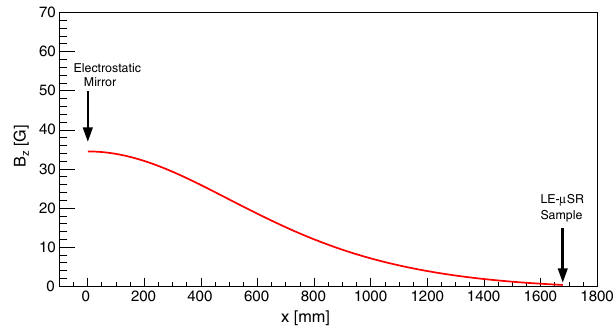
FIG. 11. Stray field B z of the G4beamline solenoid WSYalong the section EM-S of the LEM